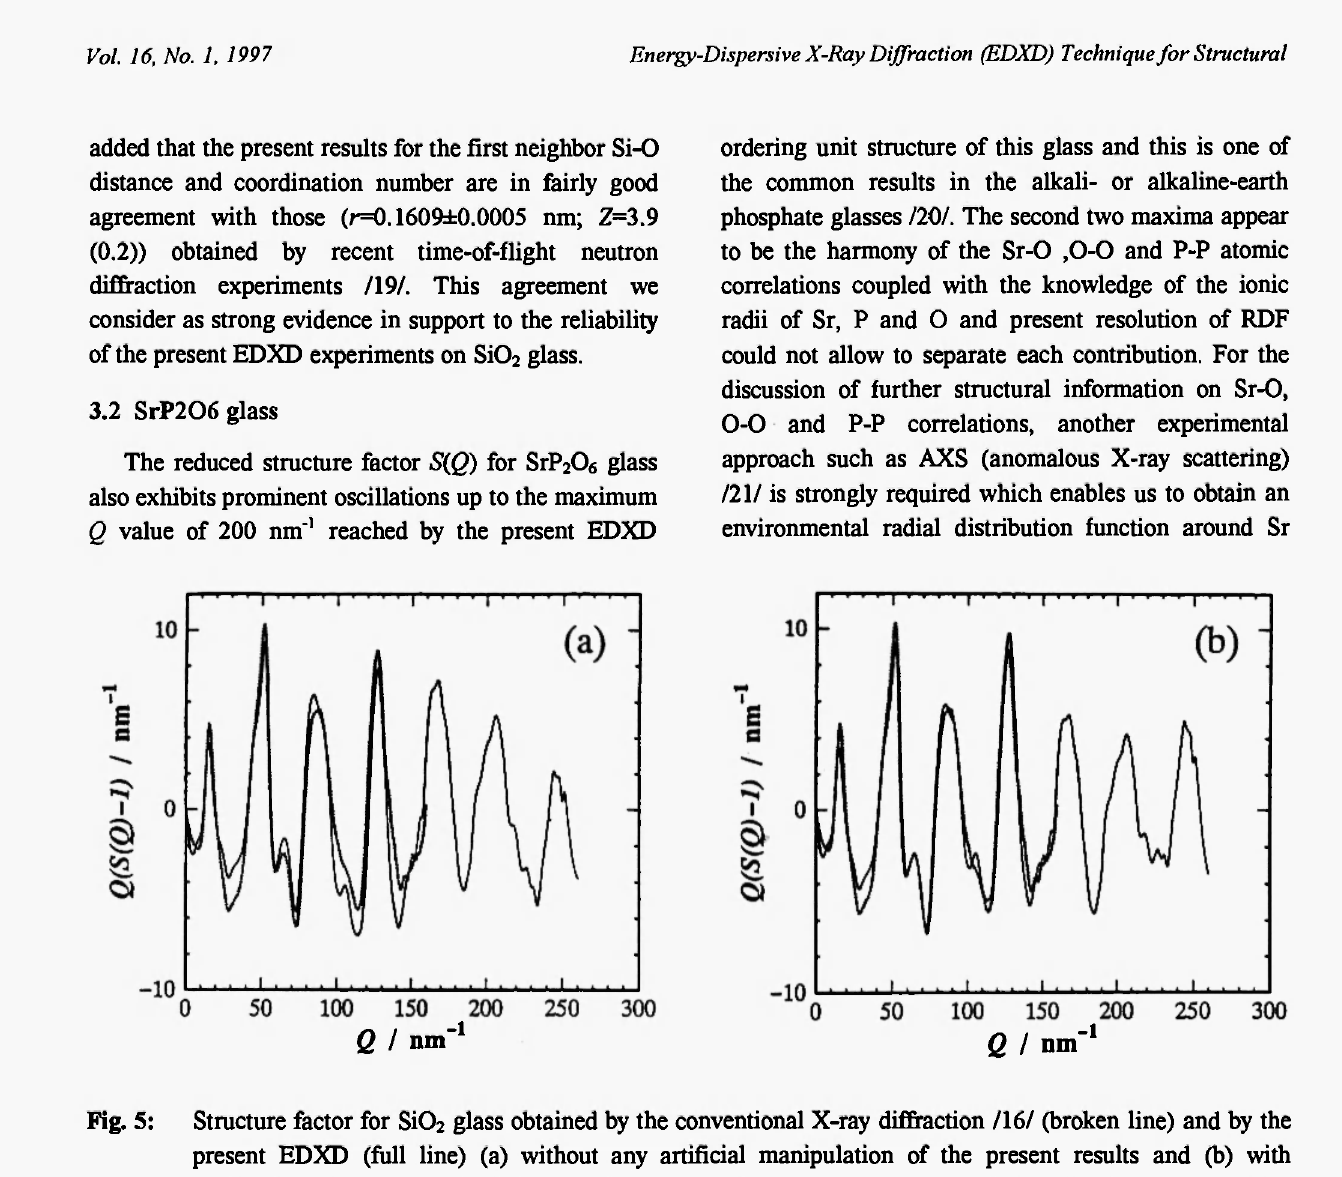
Fig. 5: Structure factor for Si0 glass obtained by the conventional X-ray diffraction /16/ (broken line) and by the 2 present EDXD (full line) (a) without any artificial manipulation of the present results and (b) with application of extra manipulation on the present data removing the oscillations in the corresponding reduced atomic distribution function G(r), at low values of r. The wide-angle data have been properly rescaled because of the different sharpening factor